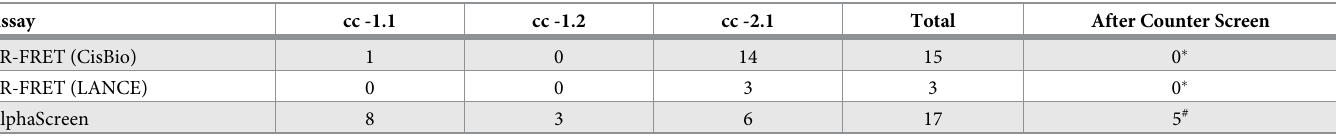
Table 5. Classification of active compounds from LOPAC screening.